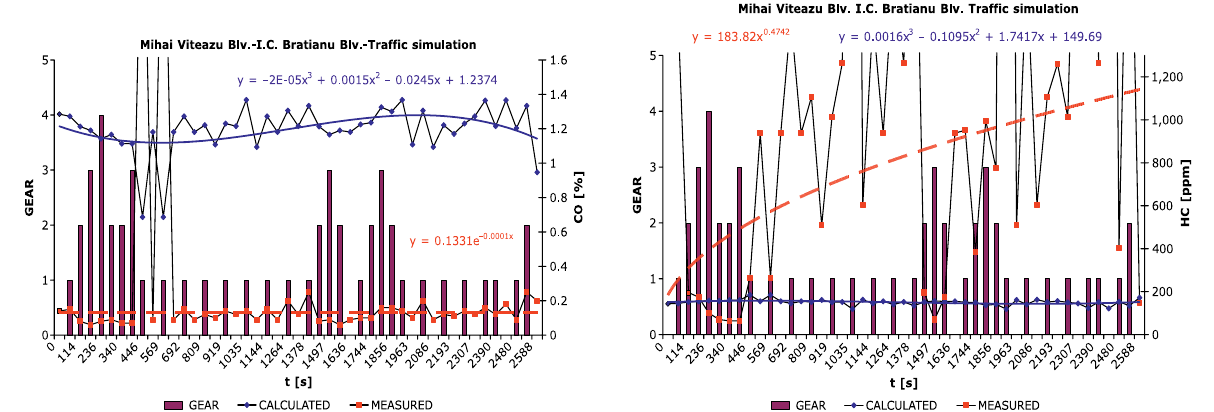
Fig. 12. HC versus time for LPG fuel (air conditioning unit is turned